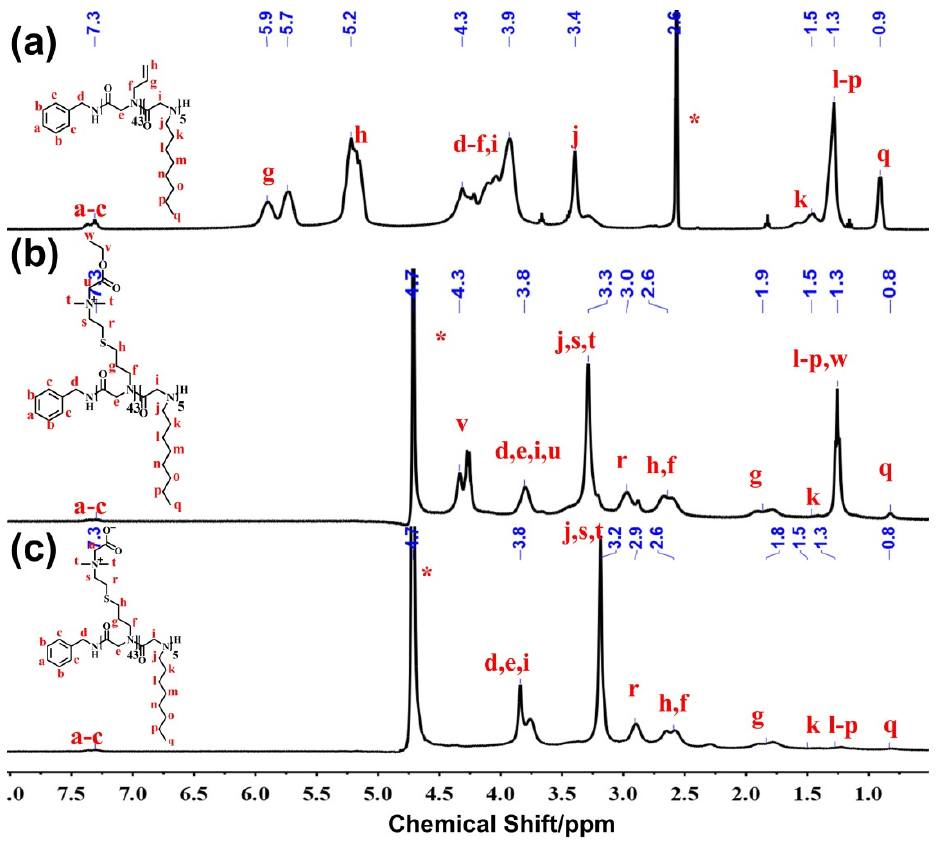
Figure 1. 1 H NMR spectra of CB-modified homopolypeptoids ( a ) PNAG, ( b ) PeptoidQA-1, and ( c ) Peptoid CB-1. * represents the solvent.